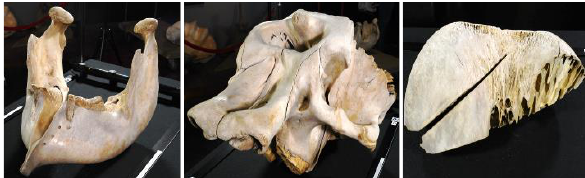
Figure 2 . Lower jaw (left) main skull (middle) and upper skull (right) of the Goethe Elephant skull.